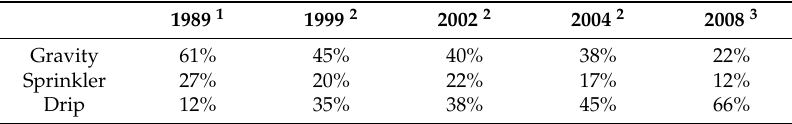
Table 1. Irrigation techniques in the Guadalquivir river basin (RB).